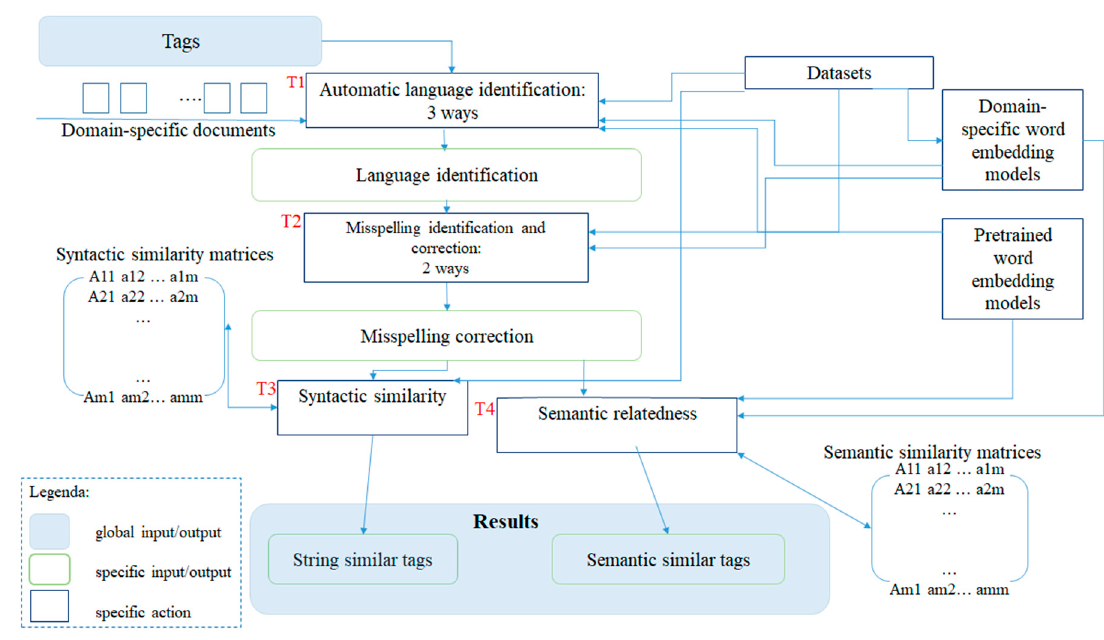
Figure 1. Proposed pipeline.